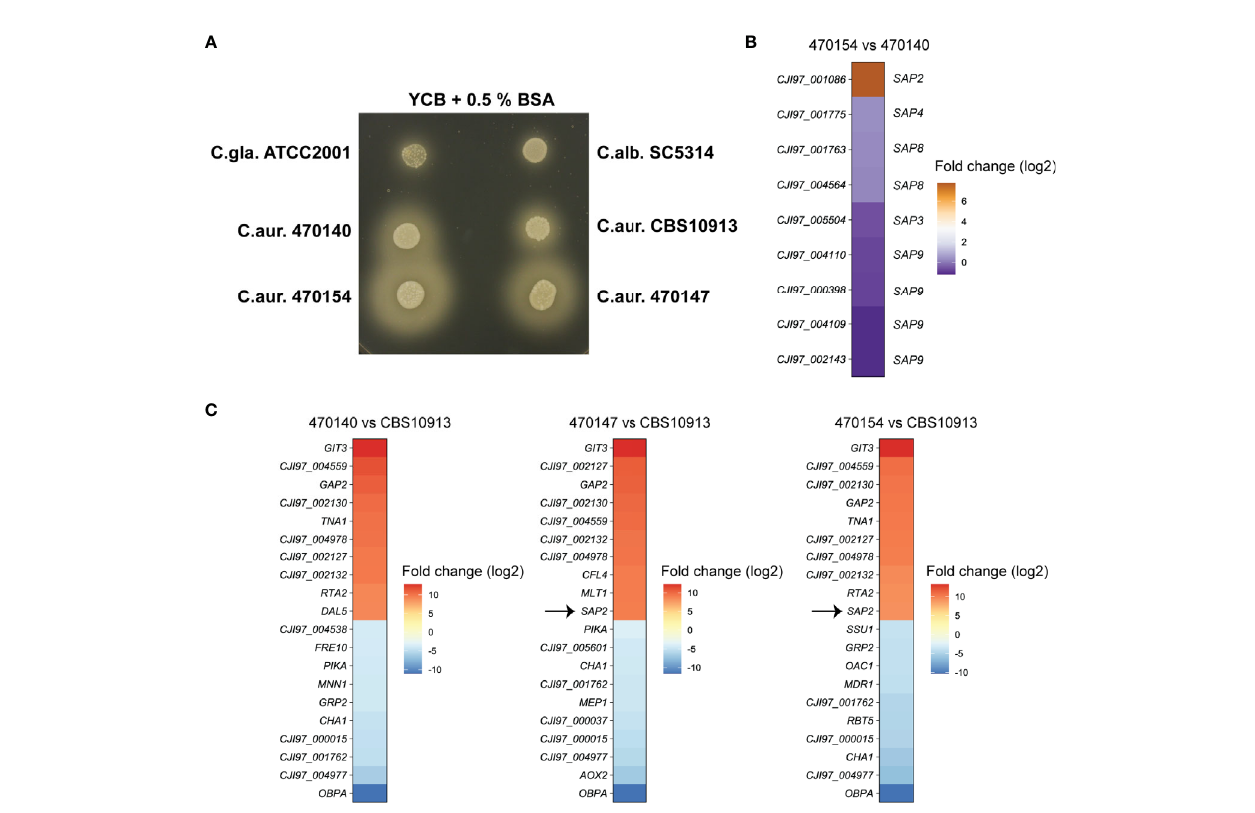
FIGURE 5 | Overexpression of C. auris SAP2 increases proteolytic growth. (A) The indicated strains were spotted on YCB medium supplemented with 0.5% BSA and incubated at 30°C for 3 days. Turbid zones around the colony are indicative of proteolytic activity. C.gla., C. glabrata ; C.alb., C. albicans , C.aur., C.auris . (B) Heatmap depicting the log2-fold changes in expression of C. auris genes, homologous to C. albicans secreted aspartic proteases, in strain 470154 vs 470140. Box labels on the left side show C. auris gene IDs (C. auris B11221), labels on the right side depict the corresponding C. albicans homologue based on BLASTp search results. (C) Heatmap of the top 10 up- and downregulated genes of the indicated comparison. Notably, CJI97_002130, CJI97_001762 and CJI97_004977 showed the greatest homology to C. albicans SIT1 based on BLASTp. The color code represent the log2 fold changes in gene